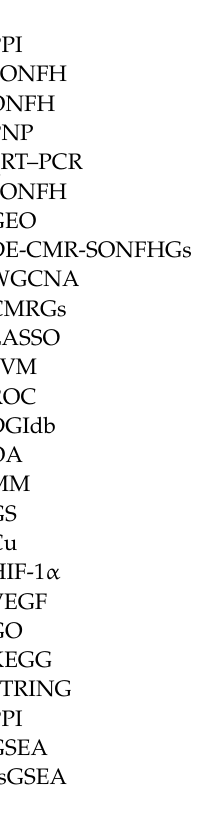
ES. Table S7. Detailed enrichment results of the single-gene GSEA-KEGG of SLC2A1 with negative ES. Table S8. Detailed enrichment results of the single-gene GSEA-KEGG of SLC2A1 with positive ES. Table S9. Pearson correlation analysis of copper death-related genes and two key